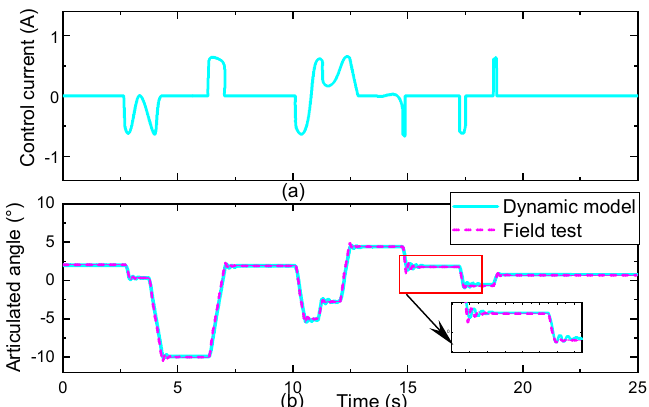
Figure 9. Articulated angle results. ( a ) Steering signal; ( b ) articulated angle.